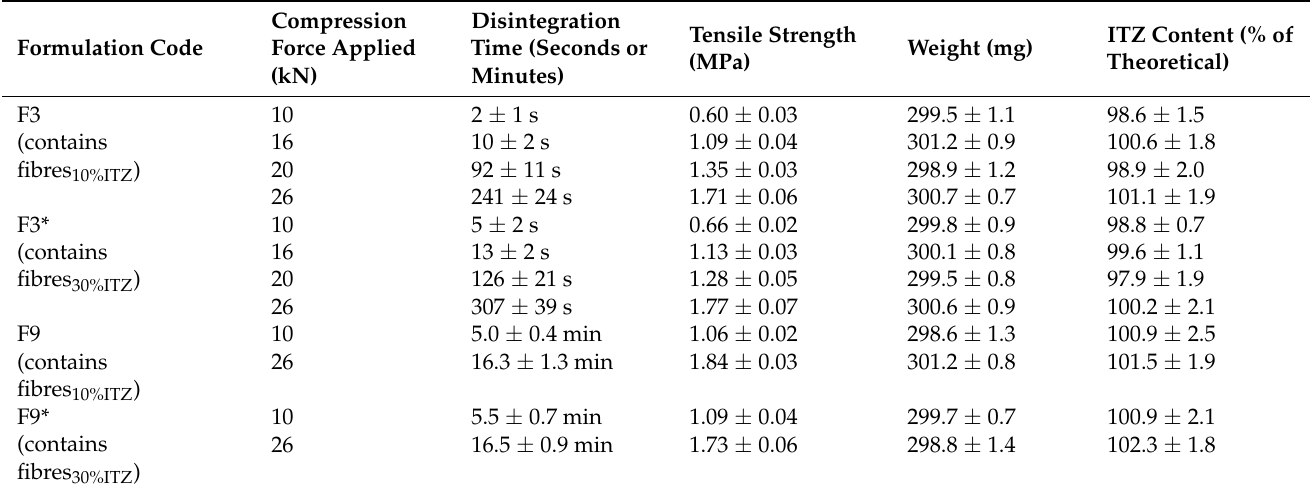
Table 3. Tablet characterisation data for tablet batches F3 and F9 [containing 10% w / w itraconazole- loaded microfibres (fibres 10%ITZ )] and F3* and F9* [containing 30% w / w itraconazole-loaded microfi- bres (fibres 30%ITZ )]. (ITZ =